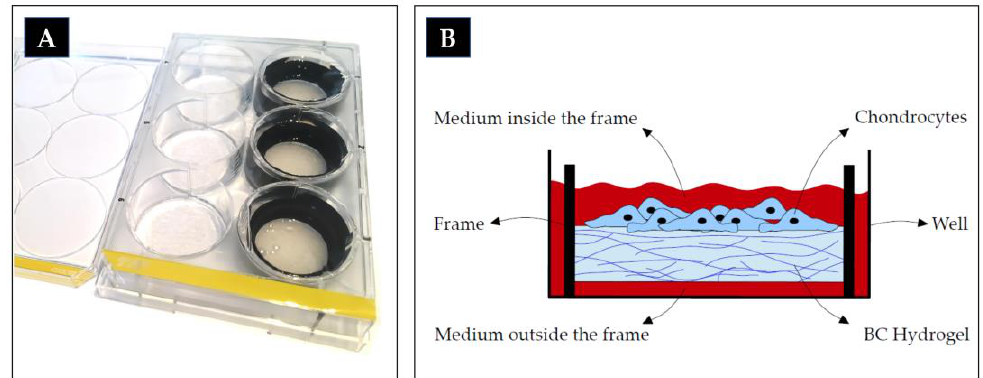
Figure 6. 6-well culture plate; in the right column filled with the bacterial cellulose (BC) hydrogel mounted on black frames ( A ); schematic diagram of a cross section of a well in cell culture ( B ).